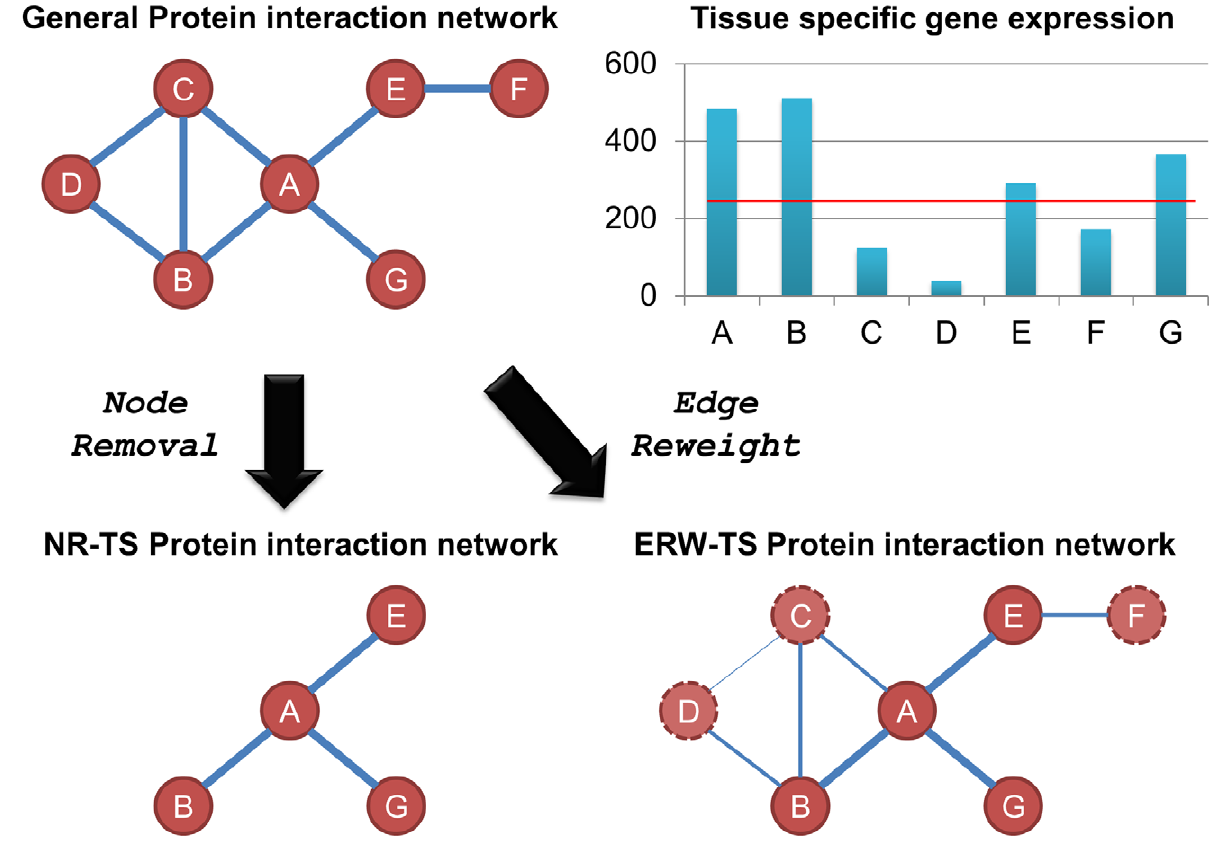
Figure 2. A summary of tissue-specific PPI network reconstruction methods. First, we determine the set of expressed genes in a given tissue based on an expression cutoff of 200 Affymetrix AD units. The set of expressed genes is then superimposed on the general PPI using one of two strategies: (a) Node Removal – removing genes which are considered unexpressed from the network. (b) Edge Reweight - Reducing the weight of an edge connecting one or two unexpressed genes. This results in a tissue specific PPI network.